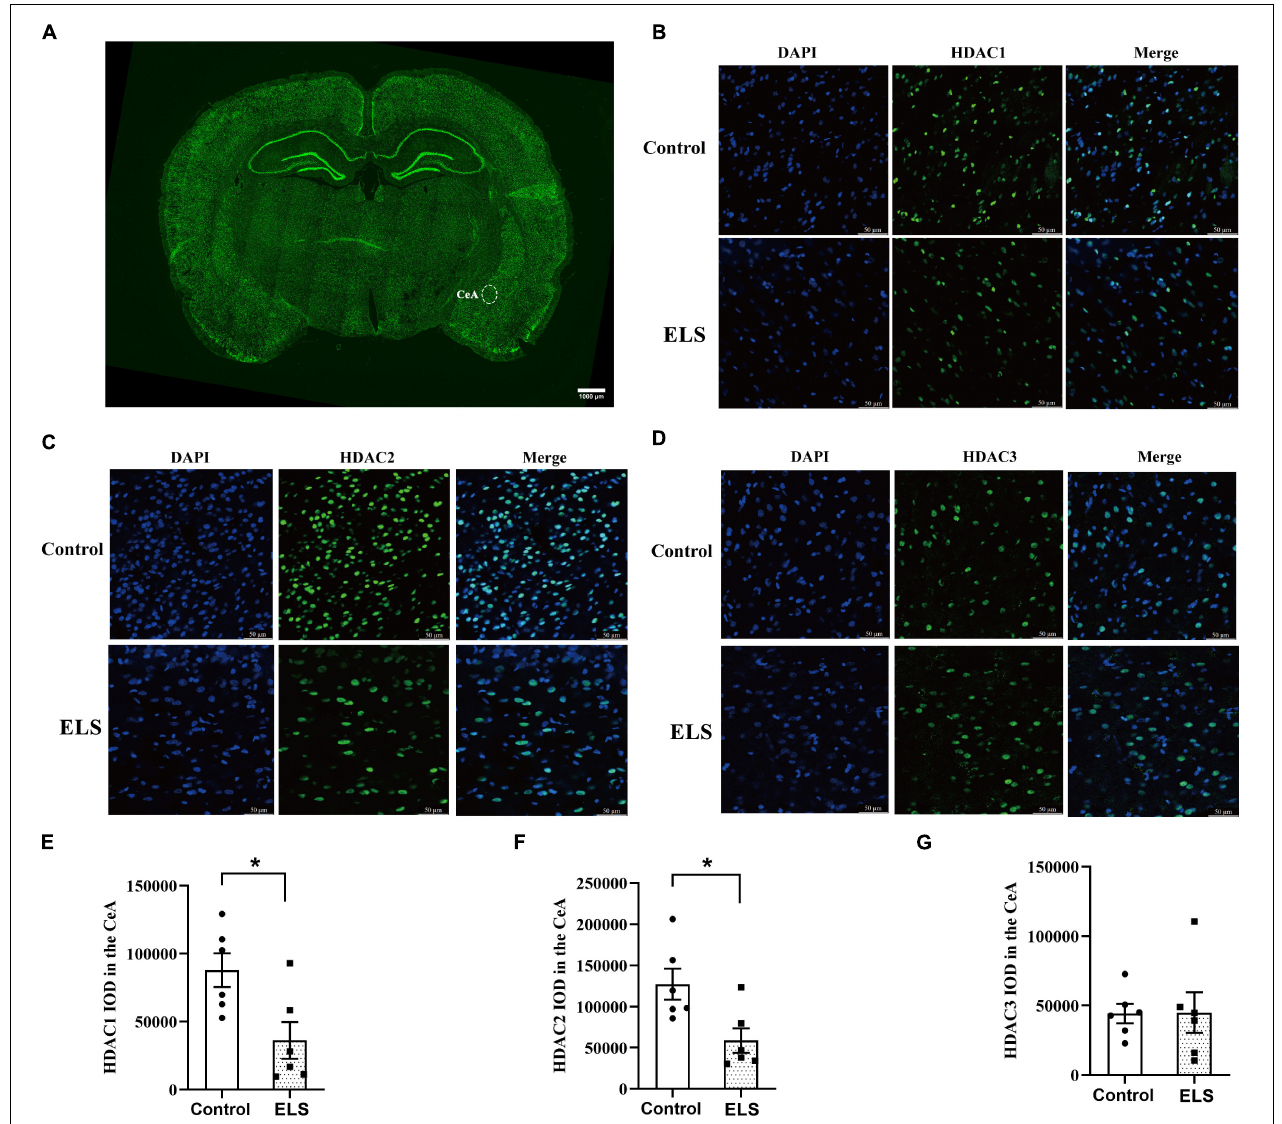
FIGURE 5 | The expression and localization of HDACs in CeA. (A) A representative picture of brain-slice immunofluorescence (HDAC2, green) from a control rat. The scale bar is 1,000 µ m. Representative confocal immunofluorescent graphs of CeA HDAC1 (B) , HDAC2 (C) , and HDAC3 (D) reactivity in ELS rats and control rats. IOD value of CeA HDAC1 (E) , HDAC2 (F) and HDAC3 (G) . The localization of CeA HDAC1, HDAC2, and HDAC3 was mainly in the nucleus (blue). The expression of CeA HDAC1 (green) and HDAC2 (green) decreased significantly in ELS rats compared to that in control rats, whereas HDAC3 (green) did not show significant difference. The scale bar is 50 µ m. * p < 0.05. N = 6. Independent samples t -test was performed (E–G) . N represents the number of rats per group. IOD, integrated optical